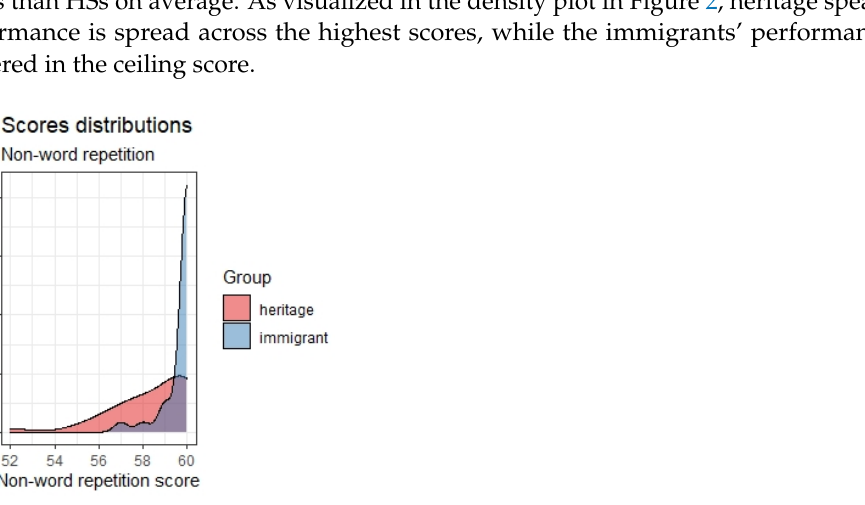
Figure 2. Density plot visualizing score distribution (x axis, with 60 ceiling score) on NWR in HSs and AIs.